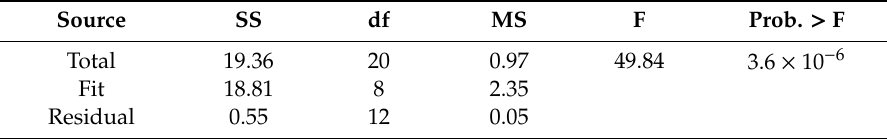
Table 3. Statistical significance of the consensus GA-PLS model for the K-F5 column.